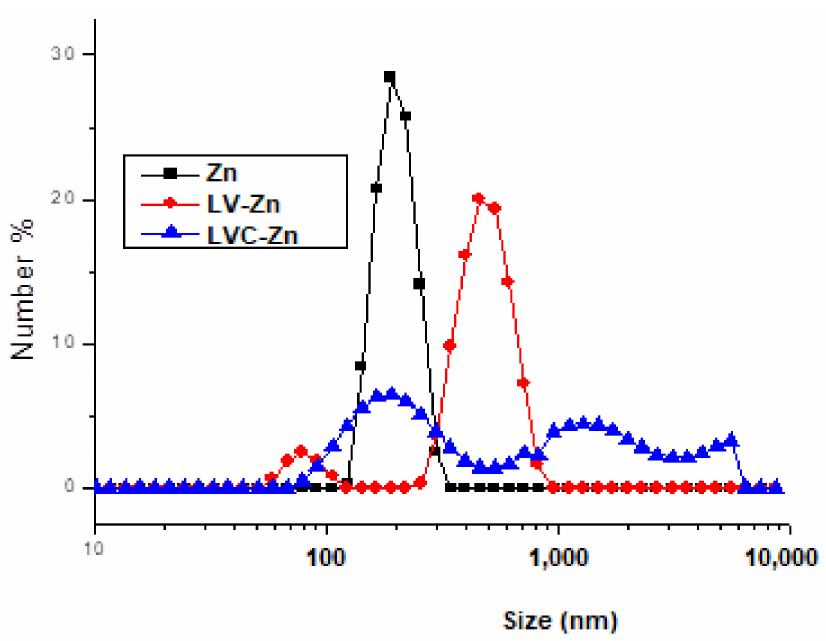
Figure 1. Size distribution frequency of Zn vesicles in solution.